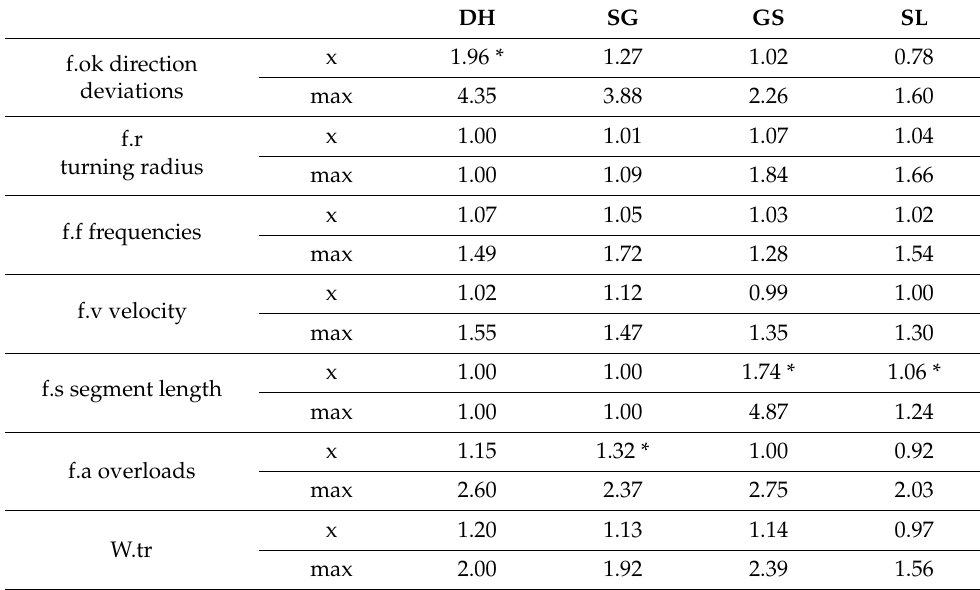
Table 2. Coefficient of difficulty with specifying the individual